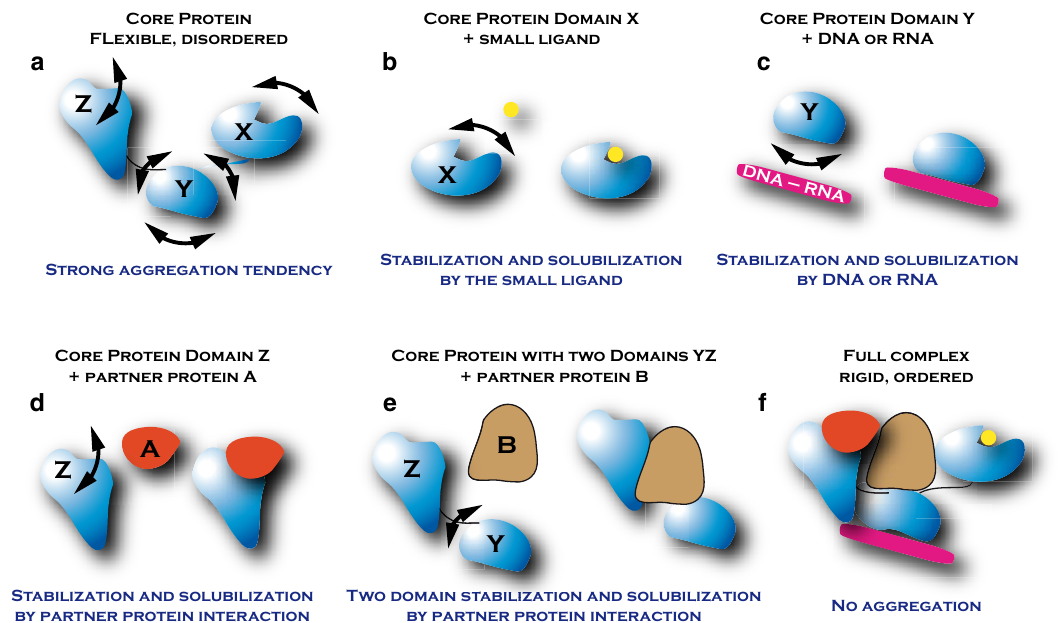
Figure 1 | Stabilization of flexible proteins. ( a ) Multi-domain proteins participating in large macromolecular complexes, with inter and/or intra domains flexibility, have a strong aggregation tendency. To characterize structurally and functionally the entire biological complex ( f ), the protein can be divided into domains which can be stabilized by small ligands ( b ), DNA/RNA ( c ) and partner proteins ( d , e